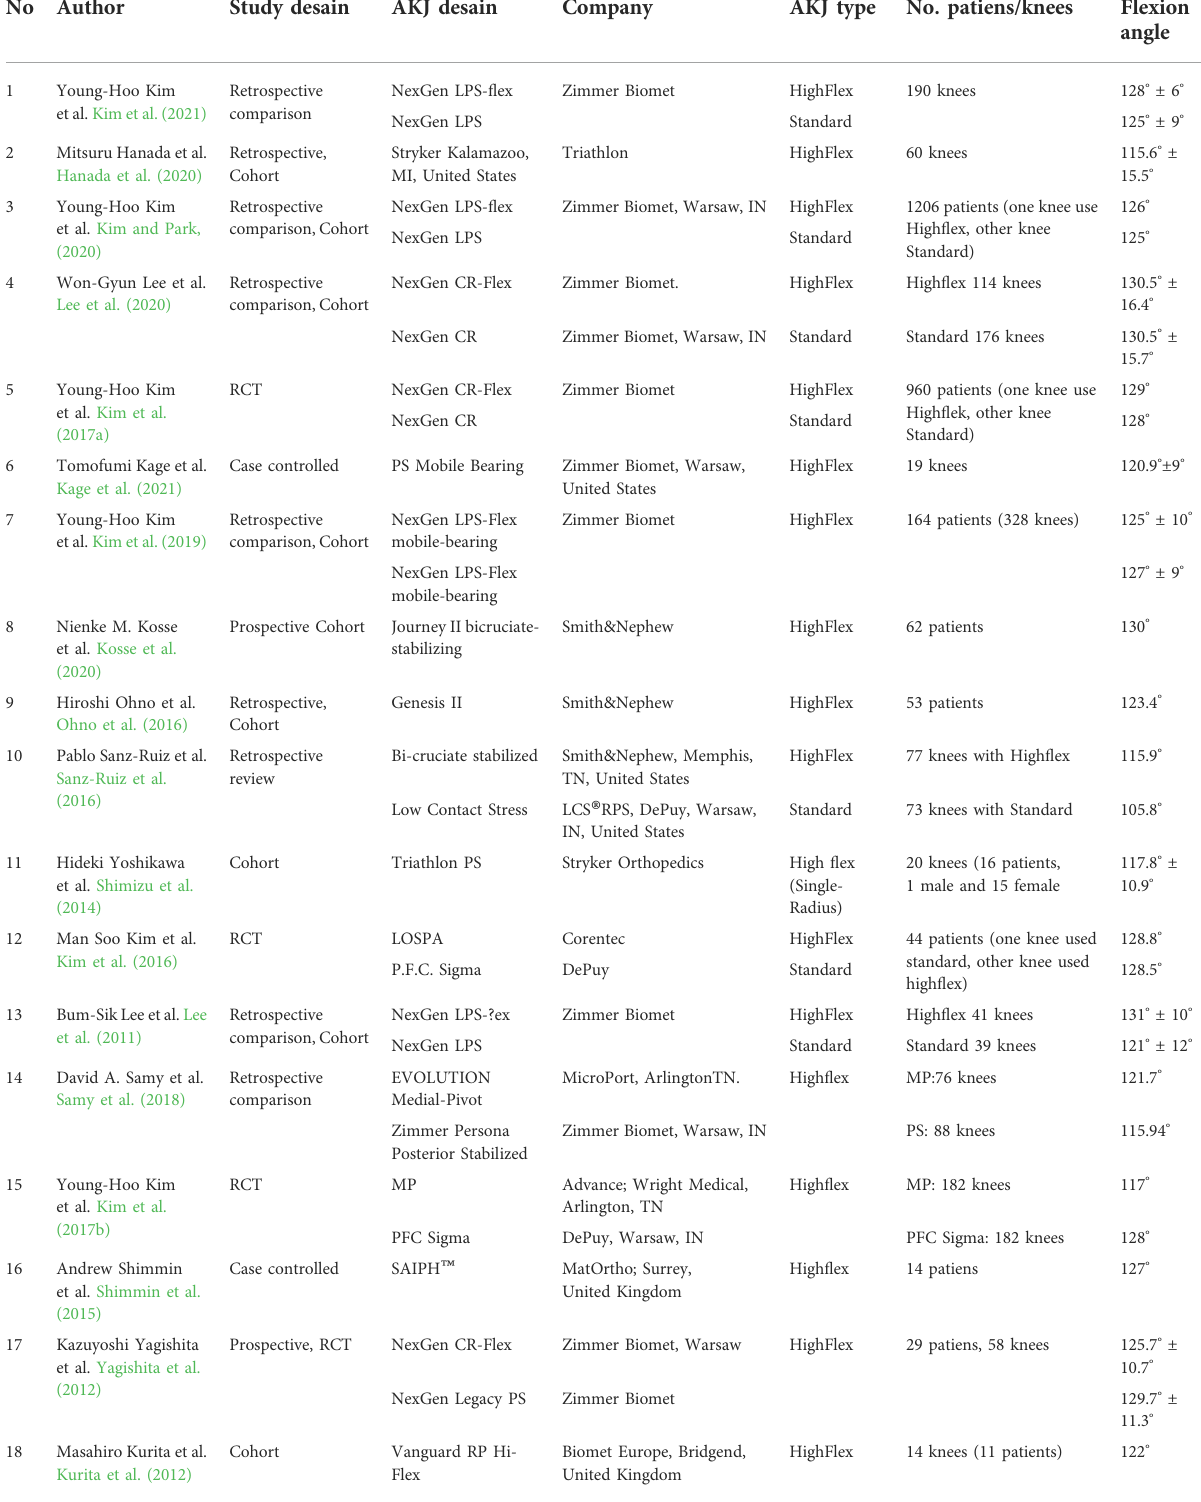
TABLE 1 Typical patient ’ s AKJ produced from different